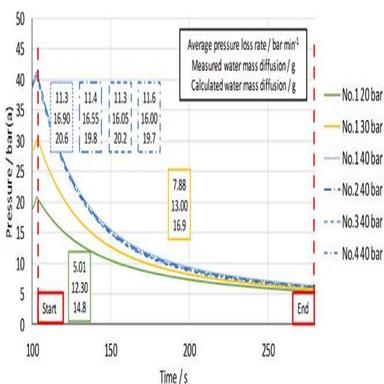
Pressure drop with measured and calculated water mass diffusion for an electrolysis stack.